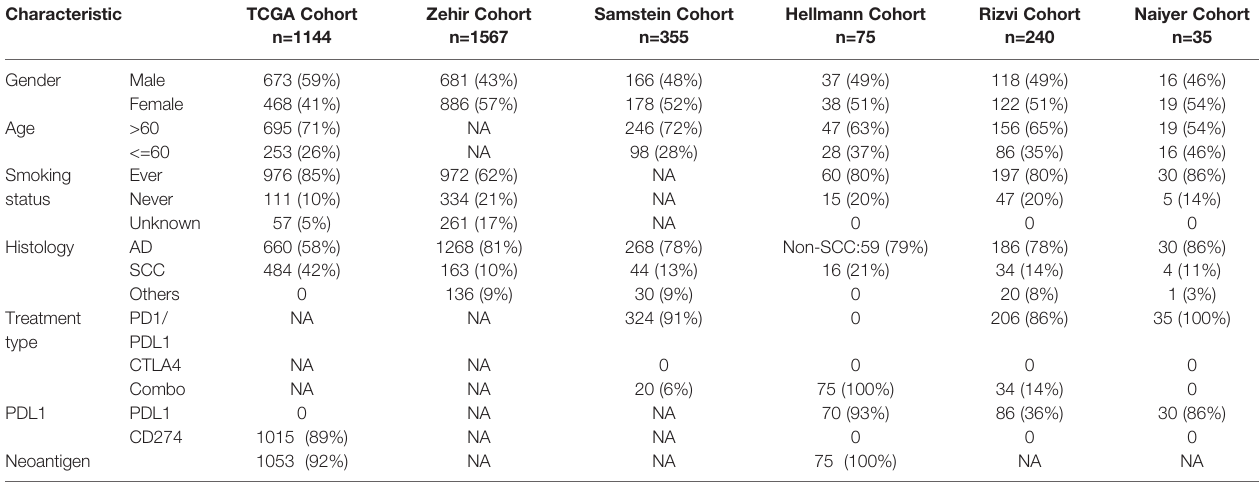
TABLE 1 | Baseline data of 3416 patients with non-small cell lung